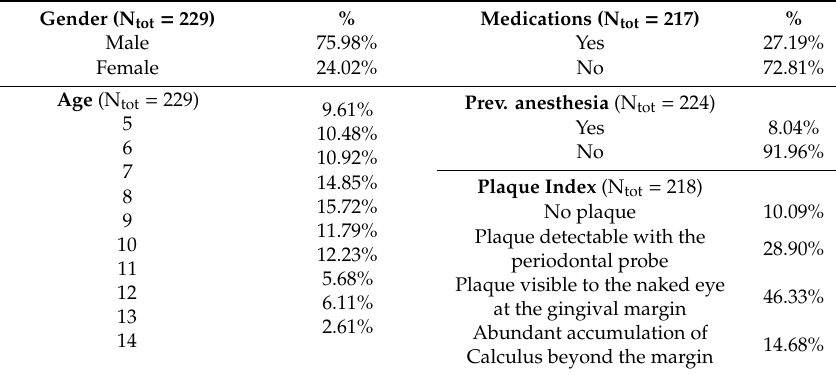
Table 1. Descriptive statistics (frequency tables) for the 12 factors considered in the study. N tot = total number of responses for each factor. For the Frankl scale, the rating is as follows. Definitely negative: Refusal of treatment, crying forcefully, fearful, or any other evidence of extreme negativism; Negative: Reluctance to accept treatment, uncooperative, some evidence of negative attitude but not pronounced, i.e., sudden withdrawal; Positive: Acceptance of treatment, at times cautious, willingness to comply with the dentist, at times with reserve, but patient follows the dentist’s directions cooperatively; Definitely positive. Good relationship with the dentist; interested in the dental procedures; laughing and enjoying the